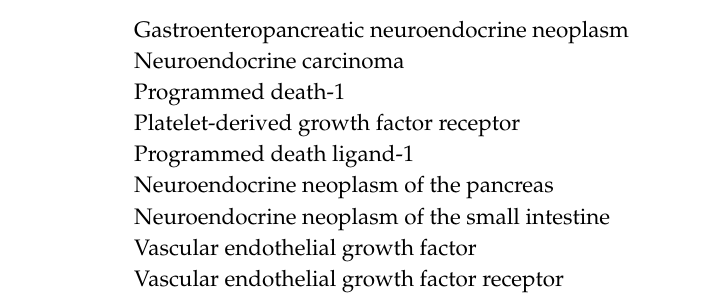
Table S1. Overview of the four grades of immunohistochemical staining for VEGFR